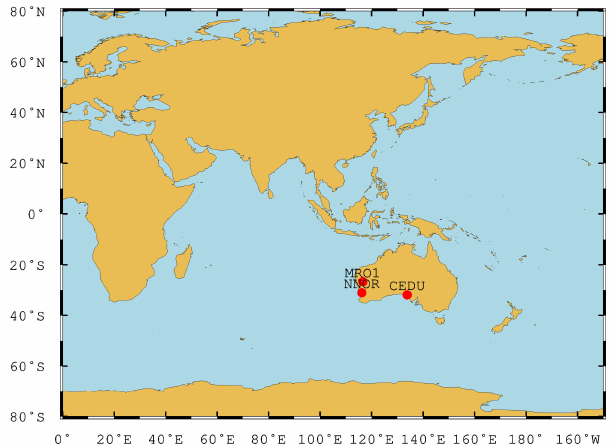
Figure 2. Distribution of the three